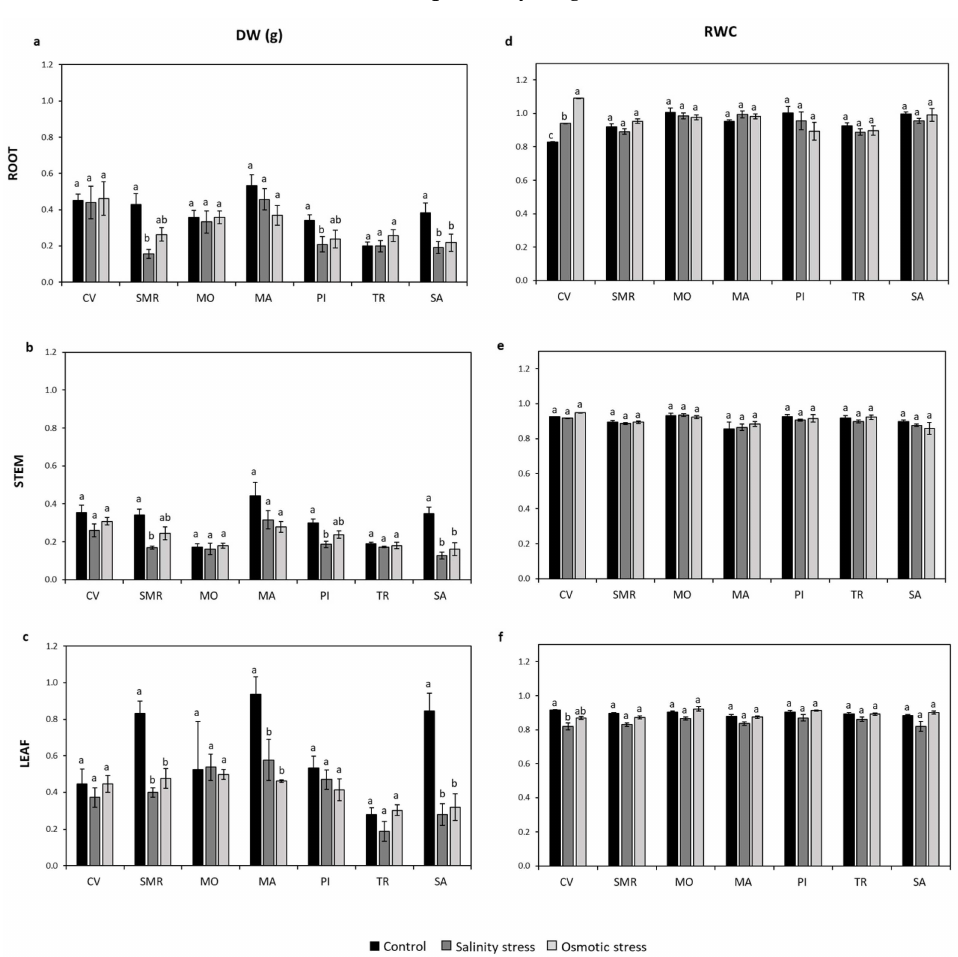
Figure 3. Dry biomass and relative water content. The dry biomass (DW; panel a – c ) and relative water content (RWC; panel d – f ) of roots, stems, and leaves of seven common bean populations, grown under controlled salt and osmotic stress conditions, were measured. Data represent the mean ( n = 4) ± standard error. A Student’s t -test was conducted to weigh the effects of different growth conditions ( p ≤ 0.05). Mean values marked with the same letter are not statistically different. CV: Ciliegino; SMR: San Michele Rosso; MO: Monachella; MA: Mascherino; PI: Pinto; TR: Tuvagliedda Rossa; SA: Suocera e